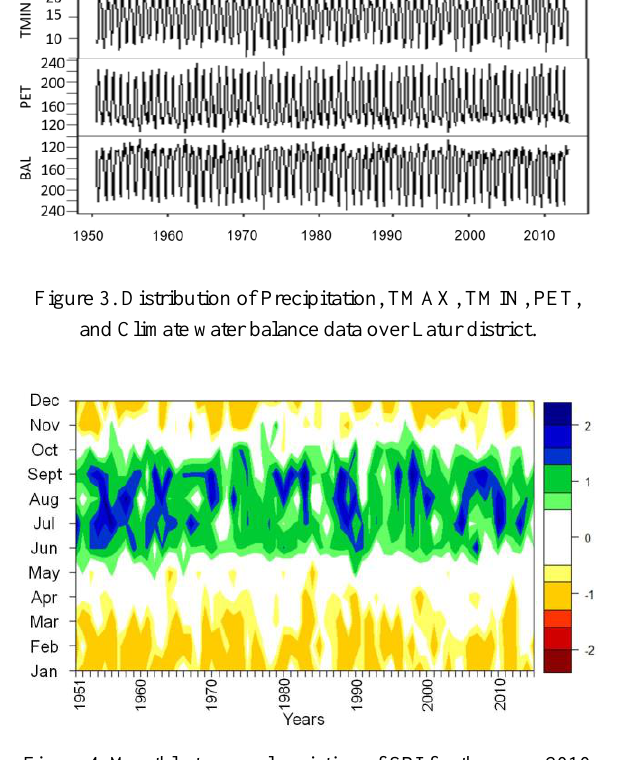
Figure 4. Monthly temporal variation of SPI for the years 2010 to 2015 over Latur district.